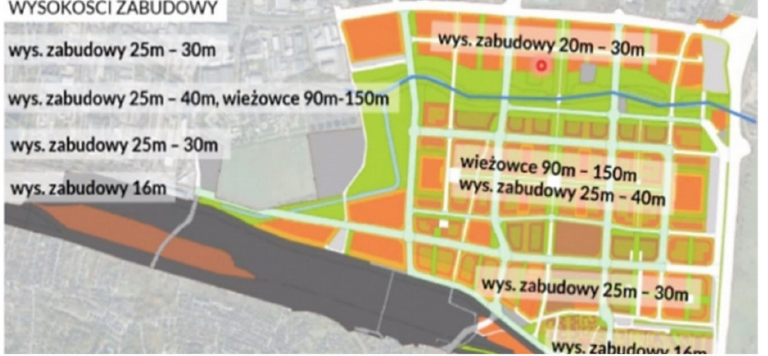
Figure 6. Changes in the approach to industrial and post-industrial areas in the B-Cracow Ry-bitwy area. A new development concept—As of 2021